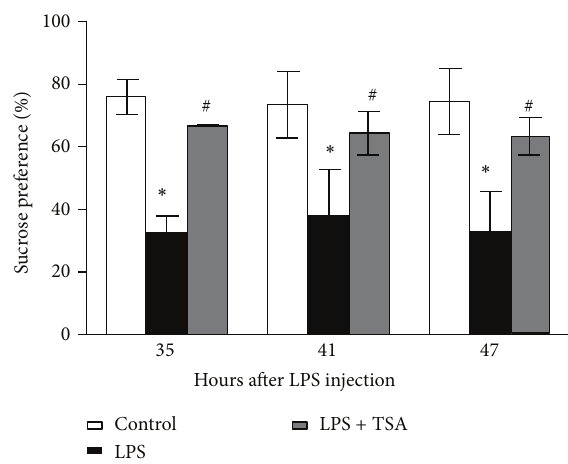
Figure 2: TSA inhibited LPS-induced anhedonia. Mice were pre- treated with saline (Controls) or TSA (0.3 mg/kg) for 1h and then intraperitoneally challenged with saline or E. coli LPS (1mg/kg). The sucrose preference was determined 35 to 47 h after LPS injection. Bars represent the mean ± SEM ( 𝑛 = 6 ). ∗ 𝑃 < 0.05 compared with the Control group; # 𝑃 < 0.05 compared with the LPS-only